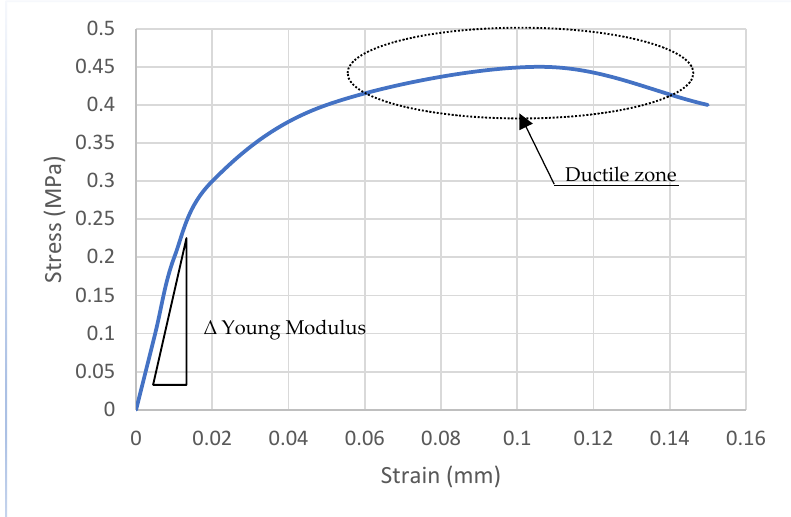
Figure 11. Typical stress-strain diagram of hemp reinforced concrete [57].